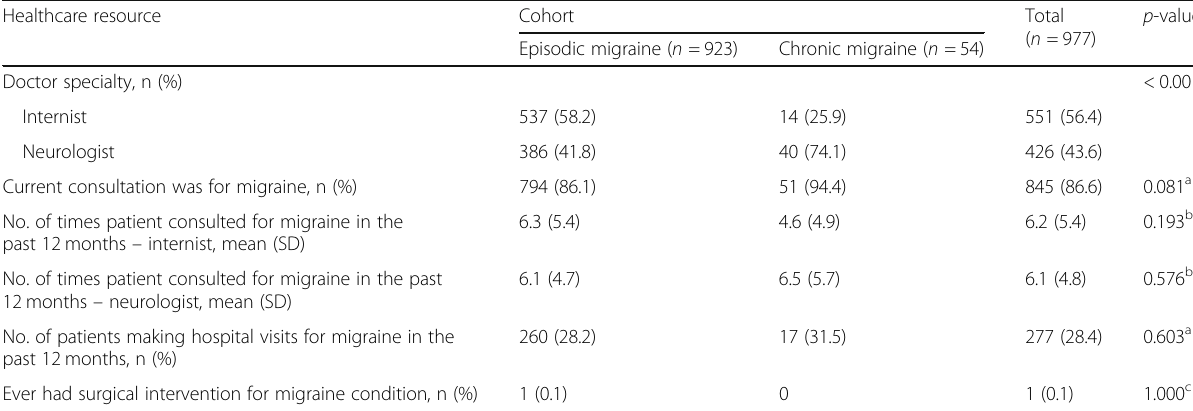
Table 2 Physician consultations and healthcare resource utilization: physician-reported data Healthcare resource Cohort